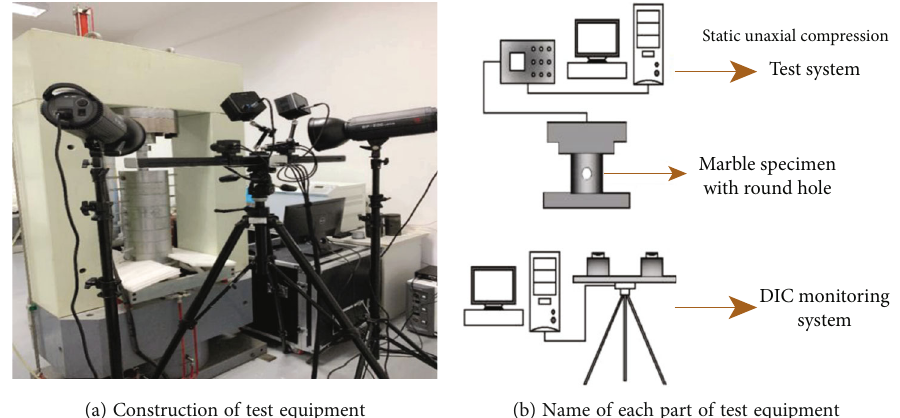
Figure 1: Schematic diagram of uniaxial compression test system and DIC monitoring system: (a) construction of test equipment; (b) name of each part of test